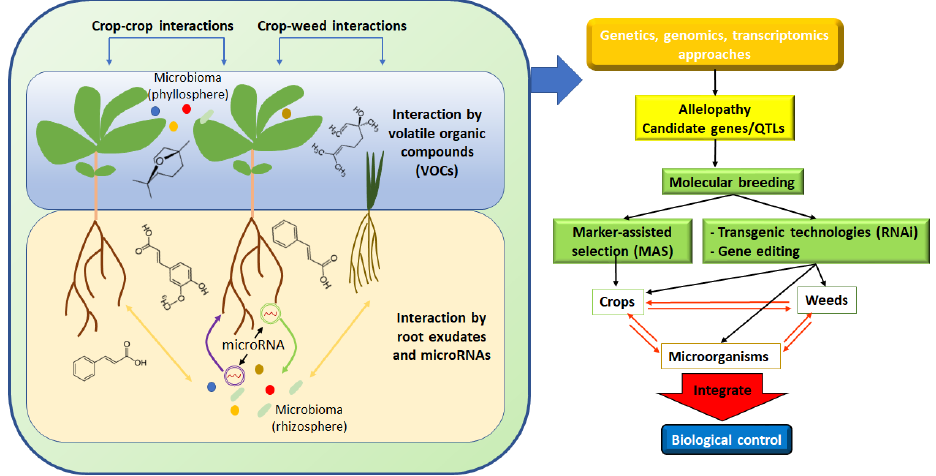
Figure 1. Schematic diagram highlighting the different allelopathic interactions. Aboveground interactions are mediated by volatile organic compounds (VOCs), whereas root exudates represent the main factor mediating allelopathic interaction in the soil. Two strategies (transgenic organisms or MAS) can be pursued to create new varieties with higher allelopathic potential. Microbiota modulates, reduces, or enhances, allelopathic interactions even through cross-kingdom microRNA exchanges.